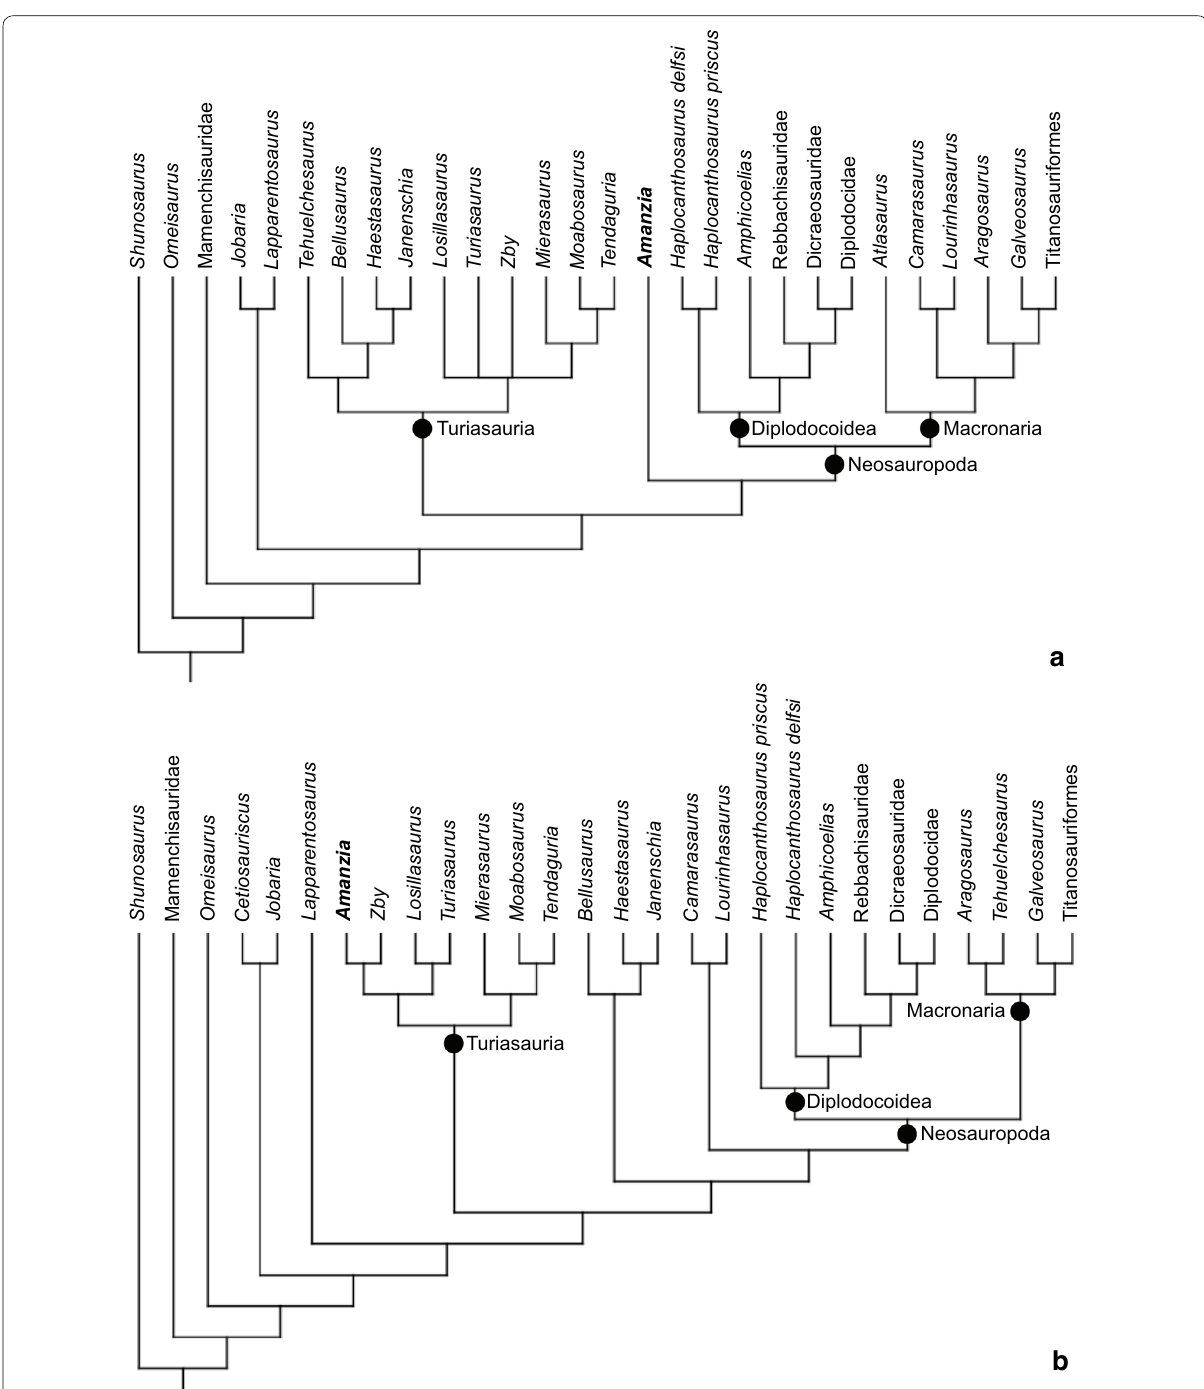
Fig. 19 Strict consensus cladogram showing the position of Amanzia greppini using a equal weights, and b extended implied weights. Several clades are collapsed for simplicity. Note that Cetiosauriscus is recovered within Dicraeosauridae in the equal weights